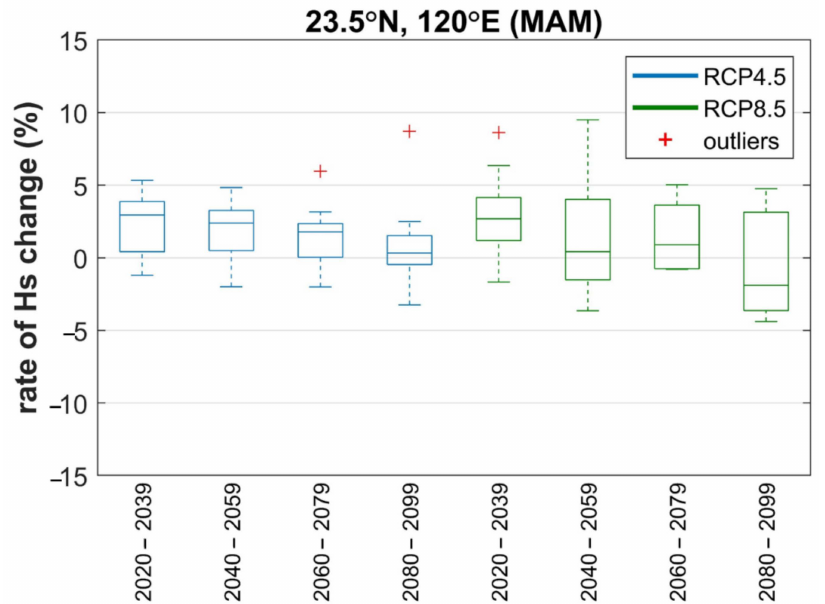
Figure 21. Box plot of rate of change in the seasonal mean of significant wave heights for each GCM, with respect to the reference period from 1980 to 2004 in the region of Taiwan in spring at 24 ◦ N, 120.15 ◦ E for various future periods (2020–2039, 2040–2059, 2060–2079, and 2080–2099) and scenarios (RCP4.5 and RCP8.5).